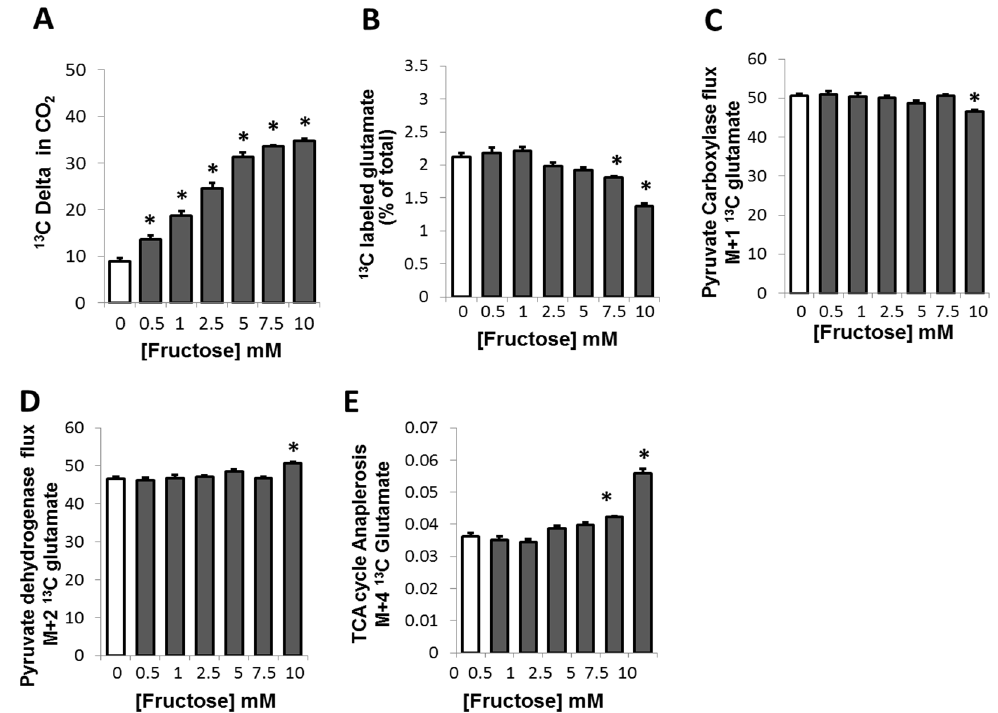
Figure 1. Modulation of 13 C glucose oxidation and glucose-derived glutamate synthesis via TCA cycle in adipocytes in the presence of fructose ( A ) Oxidation of glucose in adipocytes exposed to fructose in a medium containing a baseline amount of 5 mM of glucose. Oxidation of glucose was measured by the change (delta, Δ ) in the 13 CO 2 released in the extracellular medium measured as a ratio of 13 C/ 12 C (replacement of 12 C by 13 C) in extracellular bi-carbonate; ( B ) Extracellular release of [ 13 C]-glutamate in adipocytes exposed to fructose in a medium containing a baseline amount of 5 mM of glucose. 13 C glucose-derived glutamate release is expressed as a percentage of total glutamate released from glucose; ( C ) Glucose-derived pyruvate entry into TCA cycle via pyruvate carboxylase (PC). PC flux was measured as extracellular [3- 13 C 1 ] glutamate using the M +1 Σ mC 2 -C 5 fragment (one 13 C substitution, m / z 199 fragment, electron impact ionization) of its 13 C labeled fraction in adipocytes exposed to fructose; ( D ) Glucose-derived pyruvate entry into TCA cycle via pyruvate dehydrogenase (PDH). PDH flux was measured as extracellular [4,5- 13 C 2 ] glutamate using M +2 Σ mC 2 -C 5 fragment (two substitutions, m / z 200) fragment, electron impact ionization) of its 13 C labeled fraction in adipocytes; ( E ) TCA cycle anaplerosis in adipocytes by measuring the M +4 glutamate flux (M +4 Σ mC 2 –C 5 ) (four 13 C substitution, m / z 202 fragment, electron impact ionization). In each case, ten percent of glucose was supplied as [1,2- 13 C 2 ]- D -glucose for a period of 48 h before harvest. * p < 0.05 compared to 0 mM of